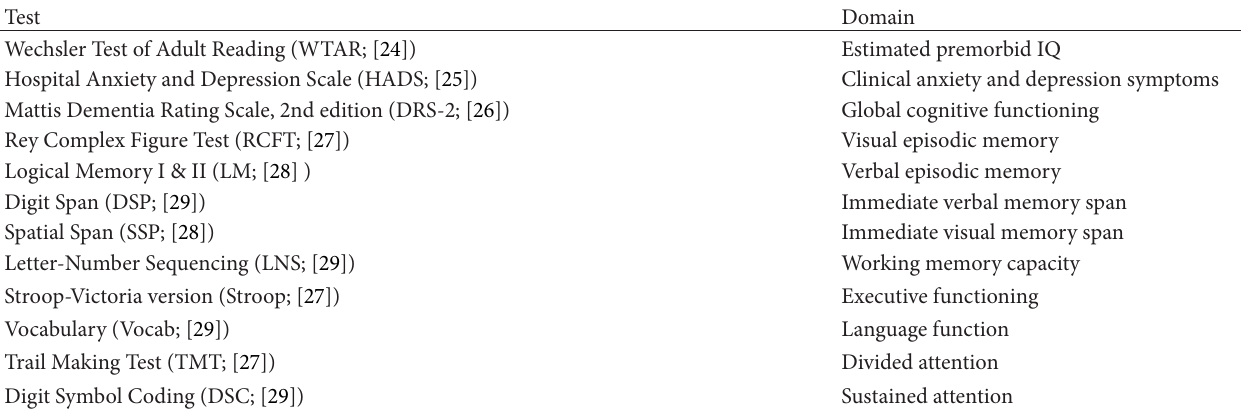
Table 1: Screening test battery used for MCI